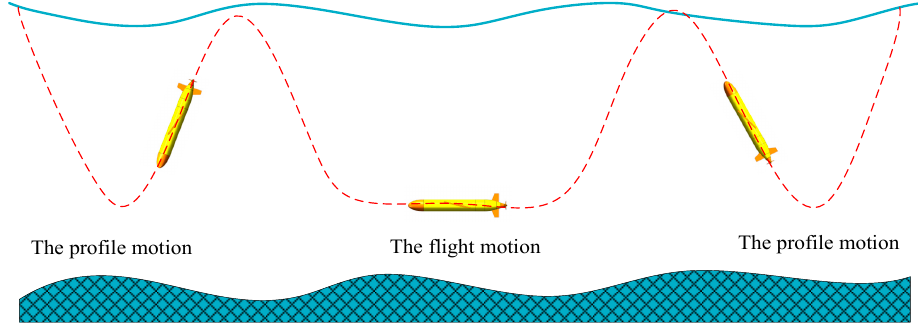
Figure 2. The motion modes of the zero-angle-of-attack glider in the vertical plane.